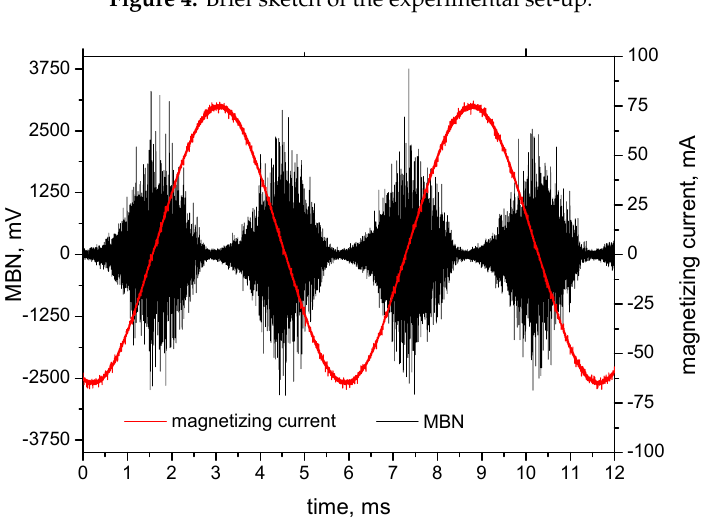
Figure 4. Brief sketch of the experimental set-up. Materials 2020 , 13 , x FOR PEER REVIEW